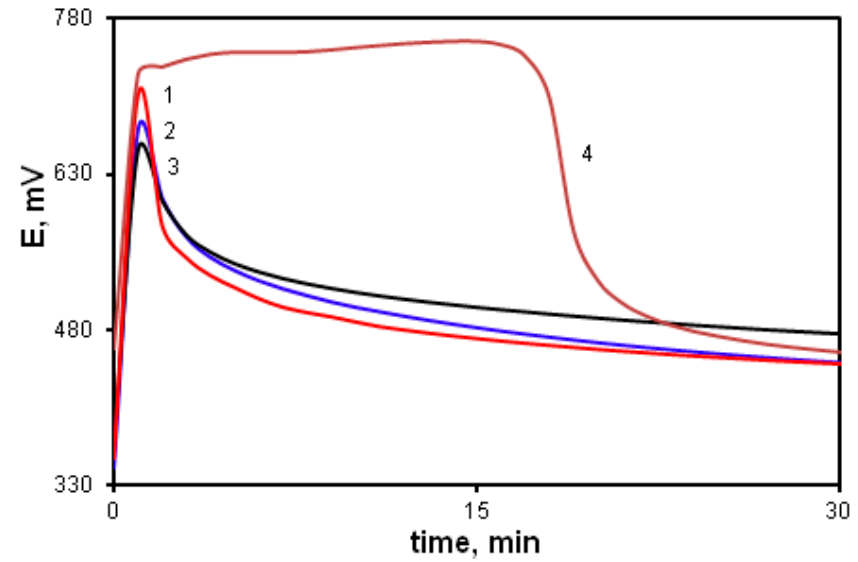
Figure 7. Time dependence of the redox potential during the oxidation reaction: [DPDCB] = 0.05 mol/L (1), 0.03 mol/L (2), 0.01 mol/L (3); [DADCB] = 0.03 mol/L (4).